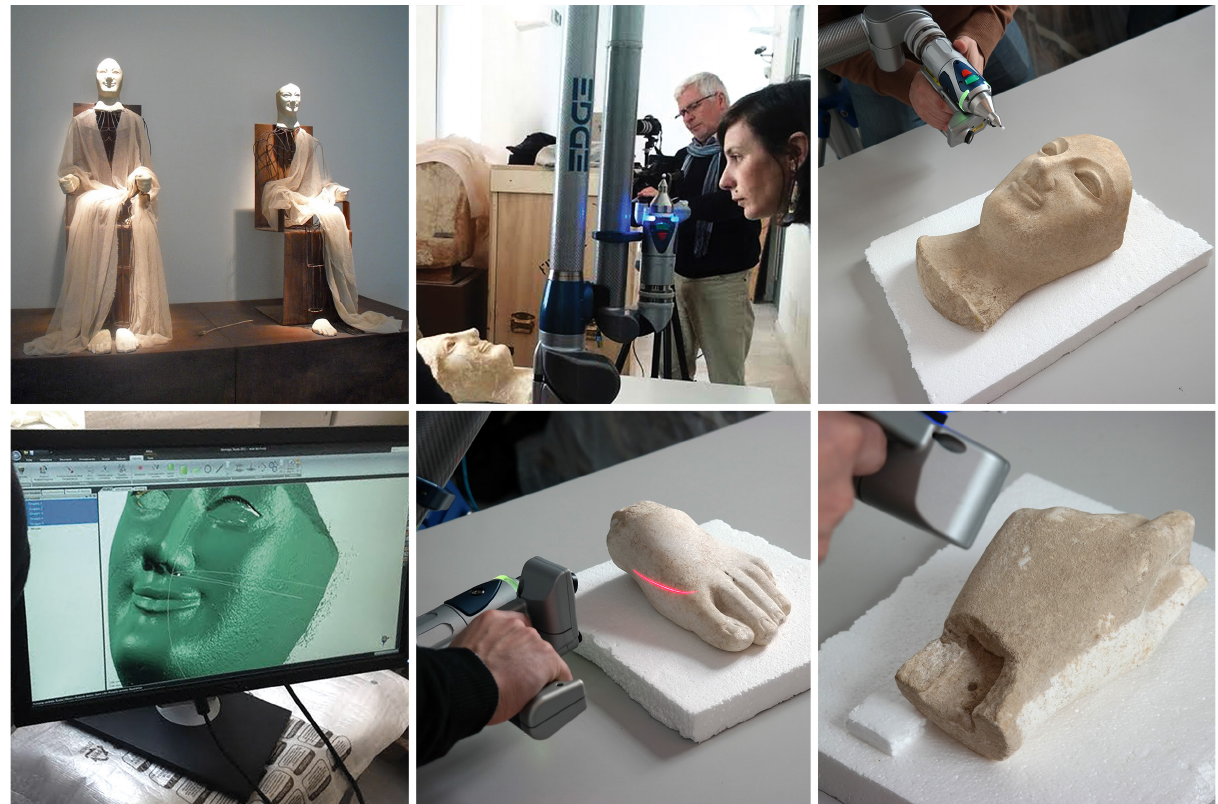
Figure 2. 3D survey activities related to the Acroliths from the ancient Greek site of